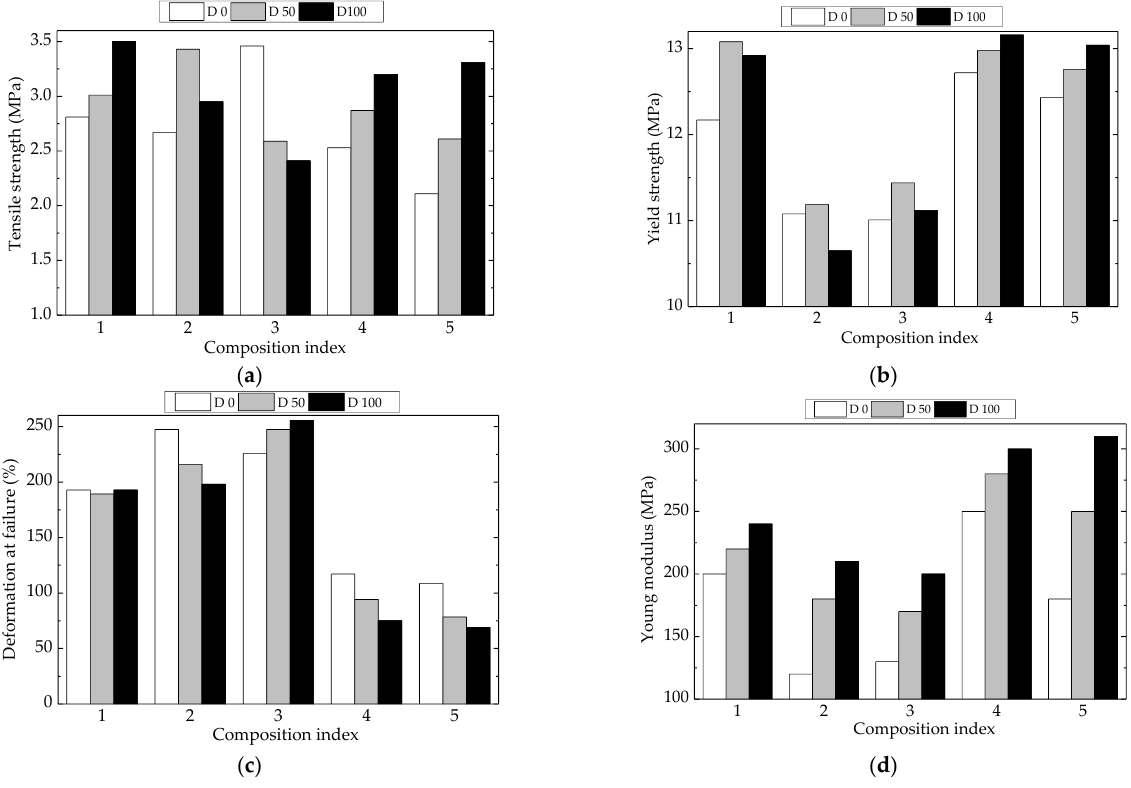
Figure 10. Mechanical properties for various LDPE-based composites at three processing doses. Types of samples: (1) LDPE/UHMWPE, (2) LDPE/HAp, (3) LDPE/HAp/RM, (4) LDPE/UHMWPE/HAp, (5) LDPE/UHMWPE/HAp/RM. ( a ) tensile strength, ( b ) yield stength, ( c ) de- formation at failure, ( d ) Young modulus.